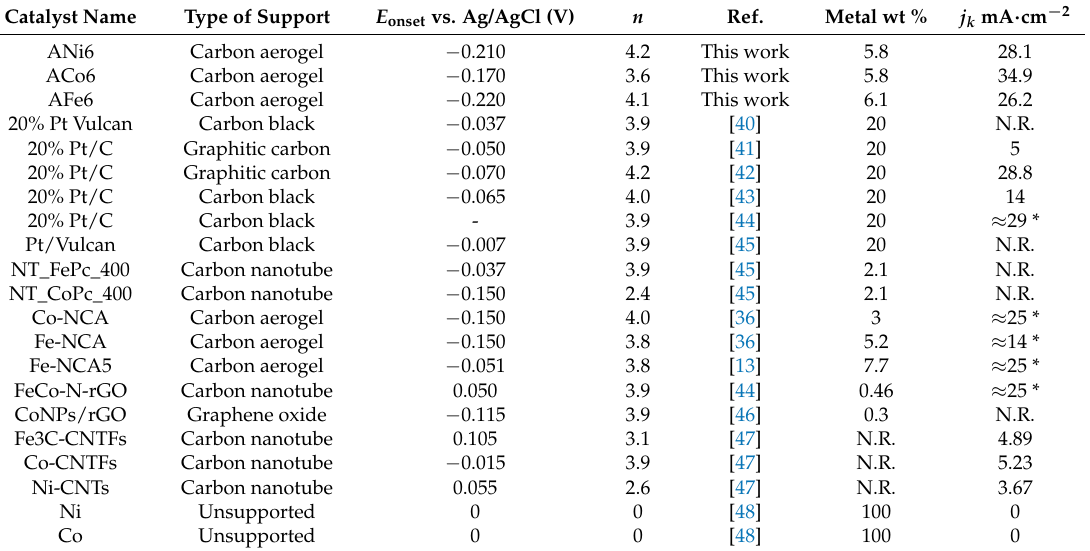
Table 4. Comparison of our electro-catalysts with others found in the literature using similar conditions and electrolyte KOH 0.1